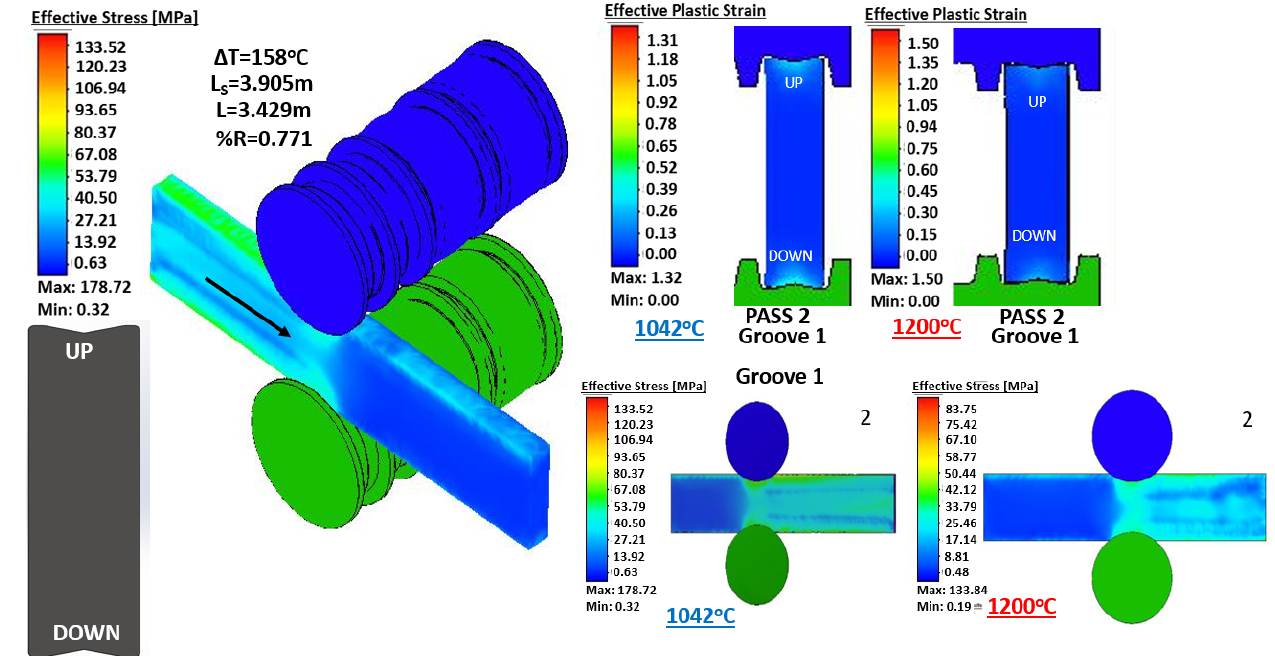
Figure 7. Comparison between hot rolling at constant temperature (1200 ◦ C) and real temperature for pass number